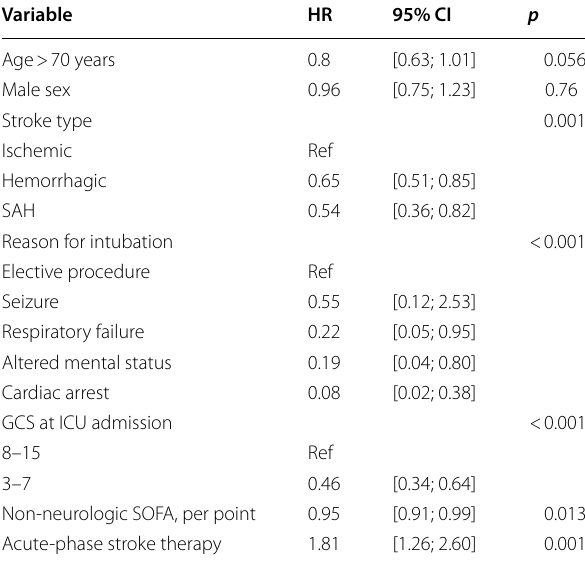
Table 3 Multivariable Cox proportional hazard